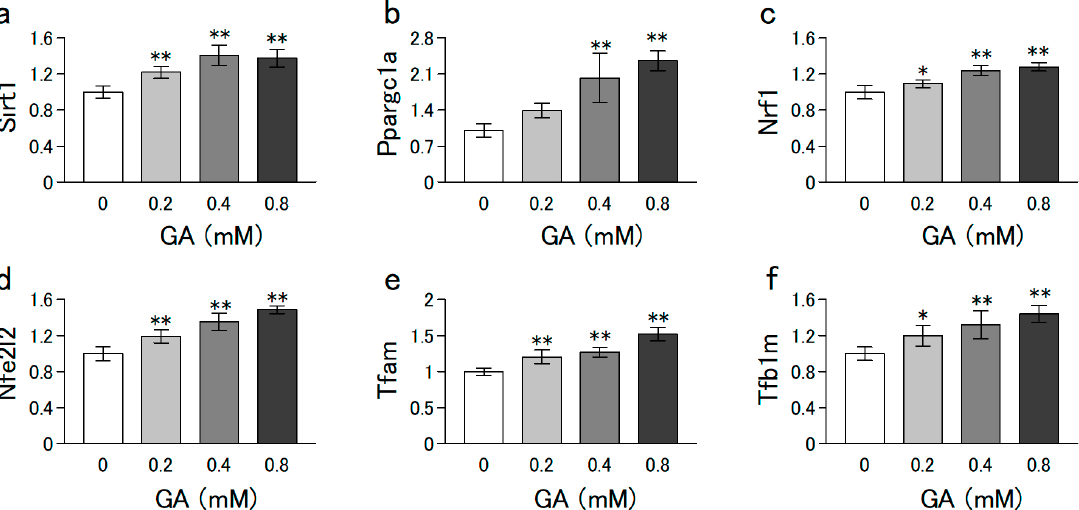
Figure 3. Effect of GA on the levels of mRNAs involved in mitochondrial biogenesis in C2C12 cells. C2C12 cells grown to subconfluence in a growth medium (without GA) were further cultured in a differentiation medium with or without GA for 6 d. mRNA levels of ( a ) Sirt1, ( b ) Ppargc1a, ( c ) Nrf1, ( d ) Nfe2l2 ( e ) Tfam ( f ) Tfb1m were measured using qPCR. Values are presented as mean ± SD of three independent experiments. Data were analyzed using a one-way ANOVA followed by Dunnett’s post hoc comparison tests. Mean value was significantly different from that of the control: ** p < 0.01, * p < 0.05.